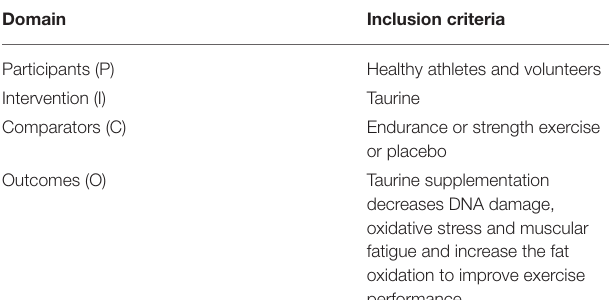
TABLE 1 | Eligibility criteria in accordance with PICO (Participants, interventions, comparators, outcomes).